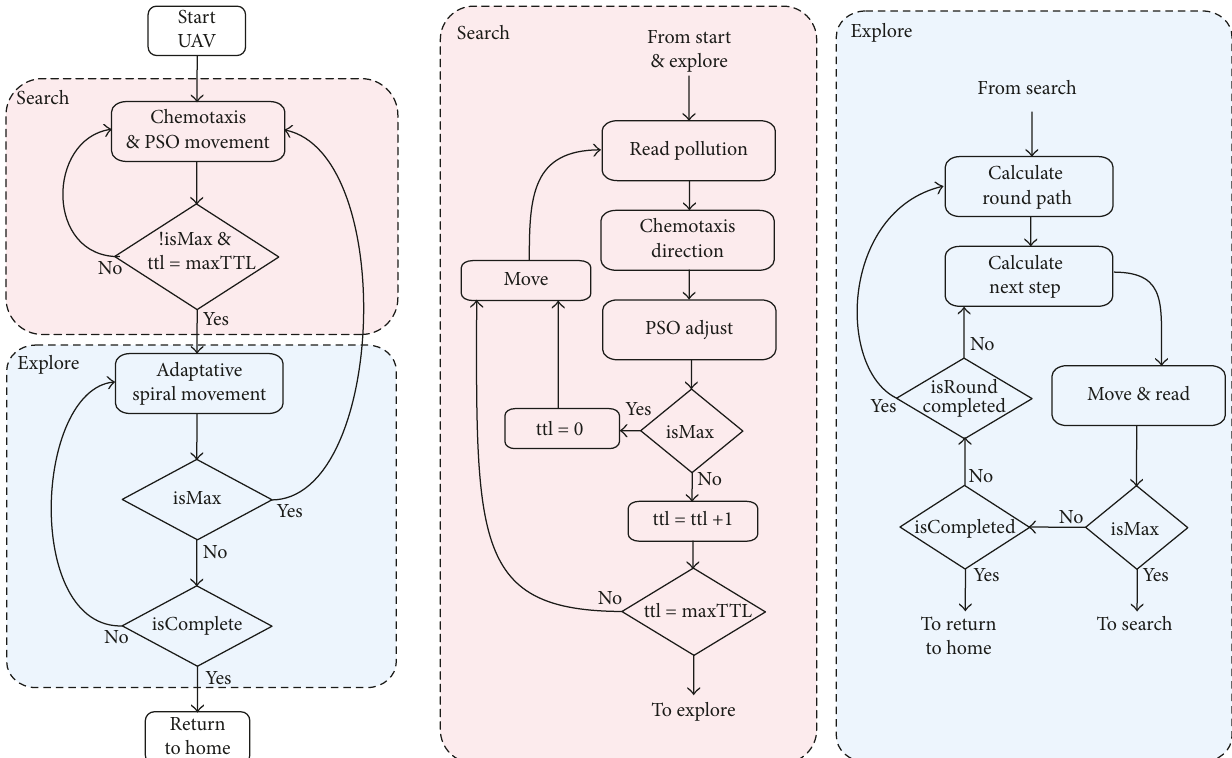
Figure 3: Overview of different states associated with the PdUC